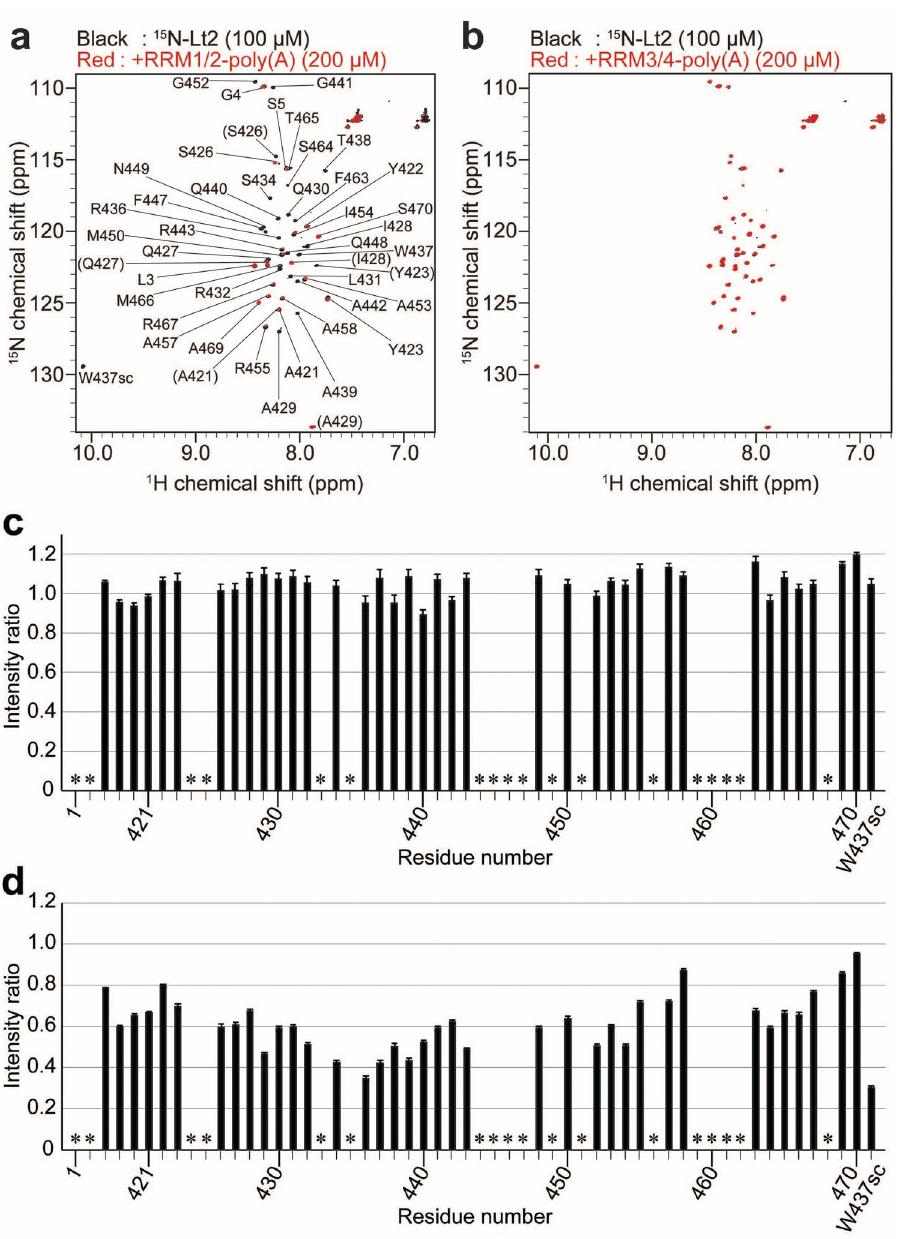
Figure 5. Identification of the RRM domain interacting with Lt2. ( a , b ) 1 H- 15 N HSQC spectra of 15 N-labelled Lt2 (100 μ M) in the presence (red) and absence (black) of RRM1/2-poly(A) (200 μ M) ( a ), and of RRM3/4- poly(A) (200 μ M) ( b ). The peak labels in the parentheses in panel (a) are for the minor peaks of the split signals. ( c , d ) PRE results of 15 N-labelled Lt2 in the presence of the A 24 -bound, spin-labelled RRM1/2/3/4. The intensity ratios of the 15 N-Lt2 NMR signals are plotted in the presence of E29C‐MTSL ( c ) and D117C-MTSL ( d ). The intensity ratios were calculated by dividing the signal intensity of the radical (paramagnetic) form MTSL by the signal intensity of the reduced (diamagnetic) form of MTSL. * Indicates Pro or residues without